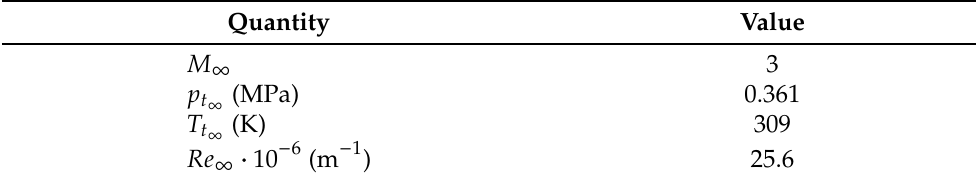
Table 13. Flow Conditions.